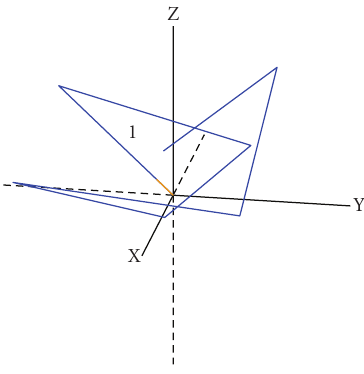
Figure 3: A GP-optimized seven-wire antenna with C = 177.